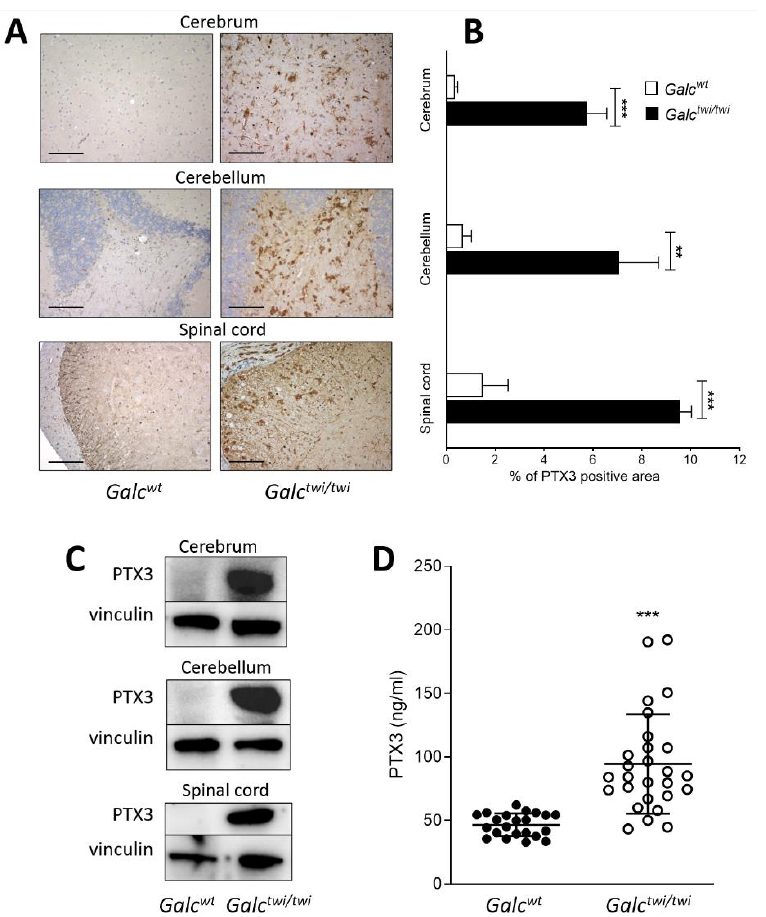
Figure 3. PTX3 protein levels in twitcher mice. ( A ) Immunohistochemical analysis shows an increased PTX3 immunoreactivity (brown) in the CNS of P35 Galc twi/twi mice when compared to control littermates; 20× magnification; scale bar: 100 μ m. ( B ) Image analysis of PTX3 positive area. Data are the mean ± S.D. of 3 samples per experimental group (5 fields/sample). ( C ) Western blot analysis of PTX3 immunoreactivity in the CNS of Galc wt and Galc twi/twi mice at P35. Vinculin was used as a loading control. ( D ) Blood samples were collected from Galc wt (n = 22) and Galc twi/twi mice (n = 27) at P28–34. Then, serum levels of PTX3 were assessed by ELISA. Each point represents one animal. Data are shown as mean ± S.D. ** p < 0.01; *** p < 0.001, Student’s t test.